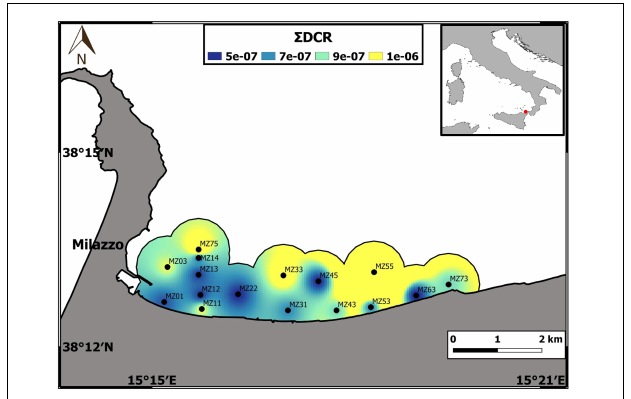
FIGURE 2 | Dermal Cancer Risk ( (cid:54) DCR) distribution in the study